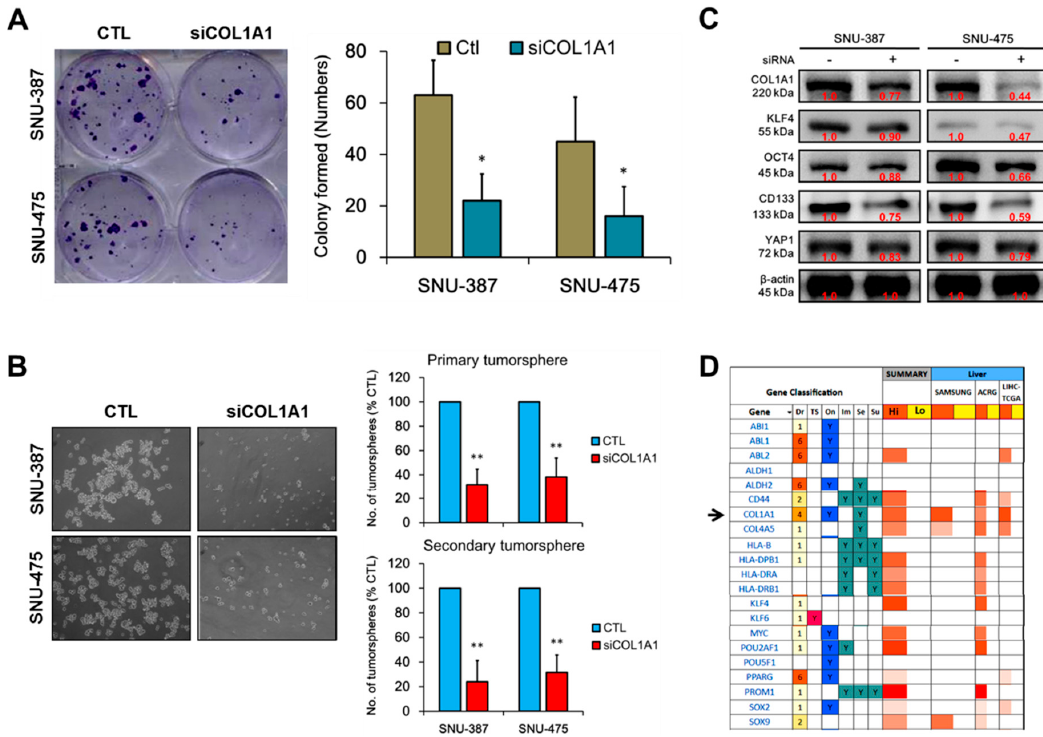
Figure 5. Loss of COL1A1 function significantly impairs colony and tumorsphere formation of HCC cells in vitro. Representative photo image (left) and histograms (right) showing the inhibitory effect of siCOL1A1 on the ( A ) colony formation potential and ( B ) number and size of primary and secondary hepatospheres formed by SNU-387 or SNU-475 cells, scale bar = 50 μ m, original magnification ×200. ( C ) Western blot images of the effect of siCOL1A1 on the expression level of COL1A1, KLF4, YAP1, OCT4 and CD133 proteins. ( D ) Functional characterization and druggability studies using the SAMSUNG HCC, Asian Cancer Research Group (ACRG) HCC and TCGA LIHC cohorts. Arrowhead, gene of interest; Dr, small molecule drugability score; TS, tumor suppressor; On, oncogene; Im, involved in immune modulation; Se, secreted gene; Su, cell surface protein. β -actin was used as a loading control. * p < 0.05, ** p < 0.01; Ctl, wild type cells not transfected with siCOL1A1.